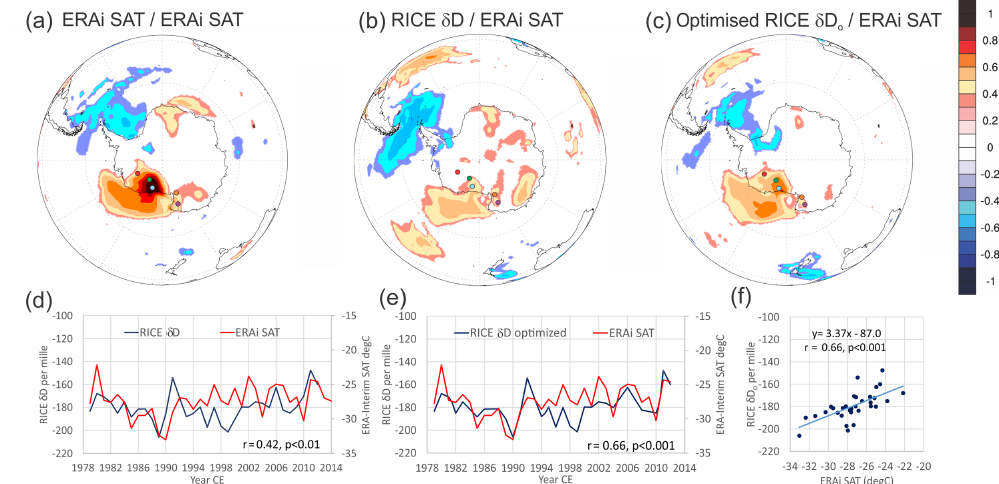
Figure 2. Spatial correlation fields exceeding ≥ 95% significance between (a) ERAi annual SAT at the RICE site with ERAi annual SAT in the Antarctic/Southern Ocean region and (b) ERAi annual SAT and annually averaged RICE δ D data; (c) as for (b) but with optimised RICE δ D data alignment within the dating uncertainty. The correlation was performed using http://climatereanalyzer.org/, University of Maine, USA. Comparison of the ERAi SAT time series with (d) RICE δ D data and (e) optimised RICE δ D data alignment. Panel (f) scatter plot between RICE δ D o and ERAi SAT. The coloured dots indicate the locations of the drill sites – RICE (blue), Siple Dome (green), WDC (red), TALDICE (pink) and Taylor Dome